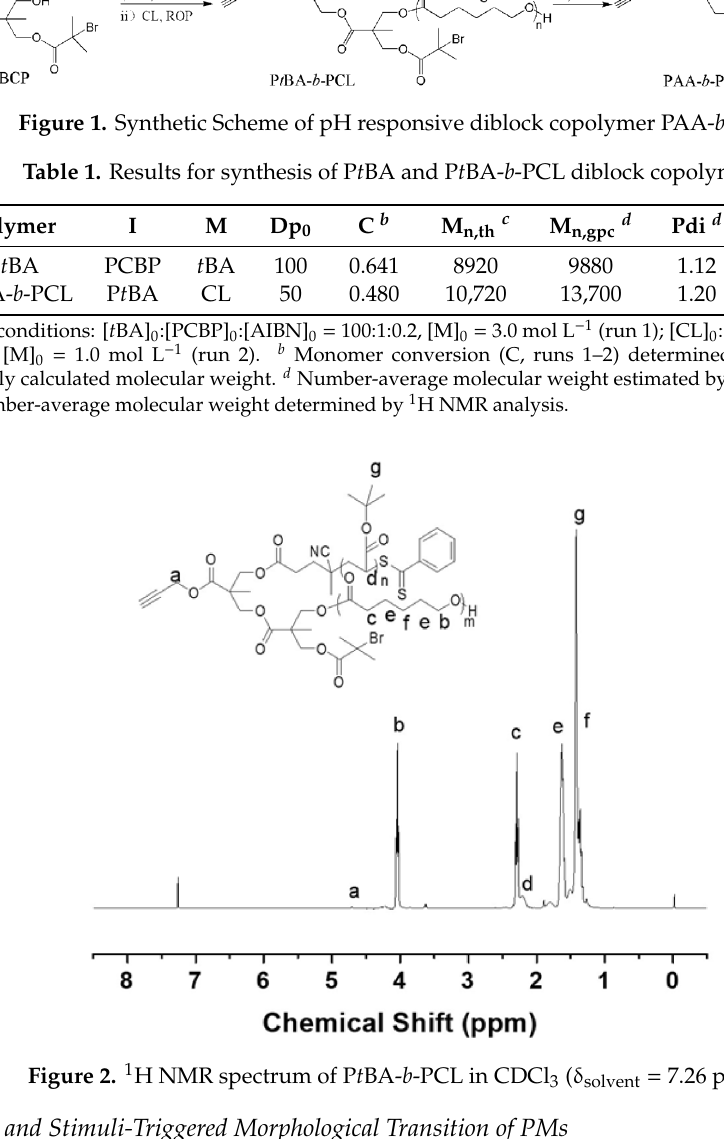
Figure 2. 1 H NMR spectrum of P t BA- b -PCL in CDCl 3 ( δ solvent = 7.26 ppm).